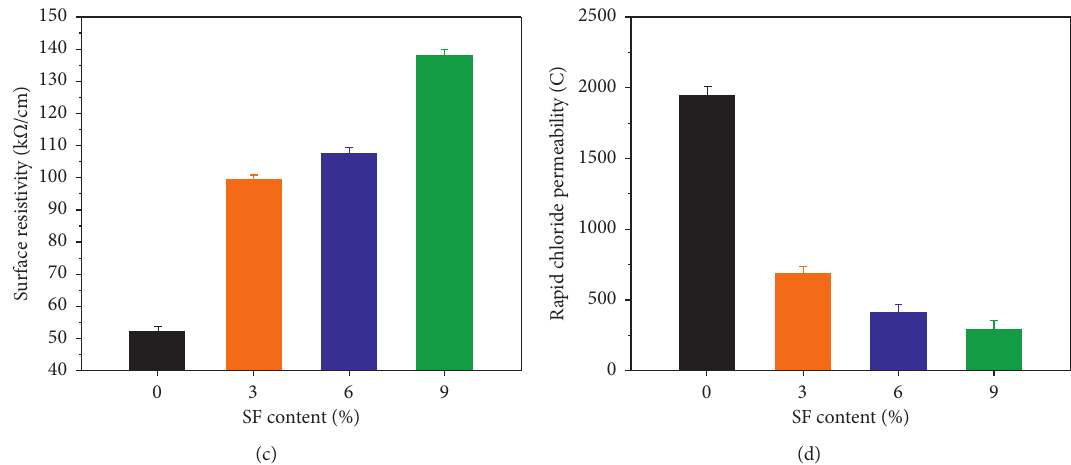
Figure 7: Influence of single-mineral admixture-SF on the performances of concrete. (a) Compressive strength. (b) Flexural strength. (c) Surface resistivity. (d) Rapid chloride